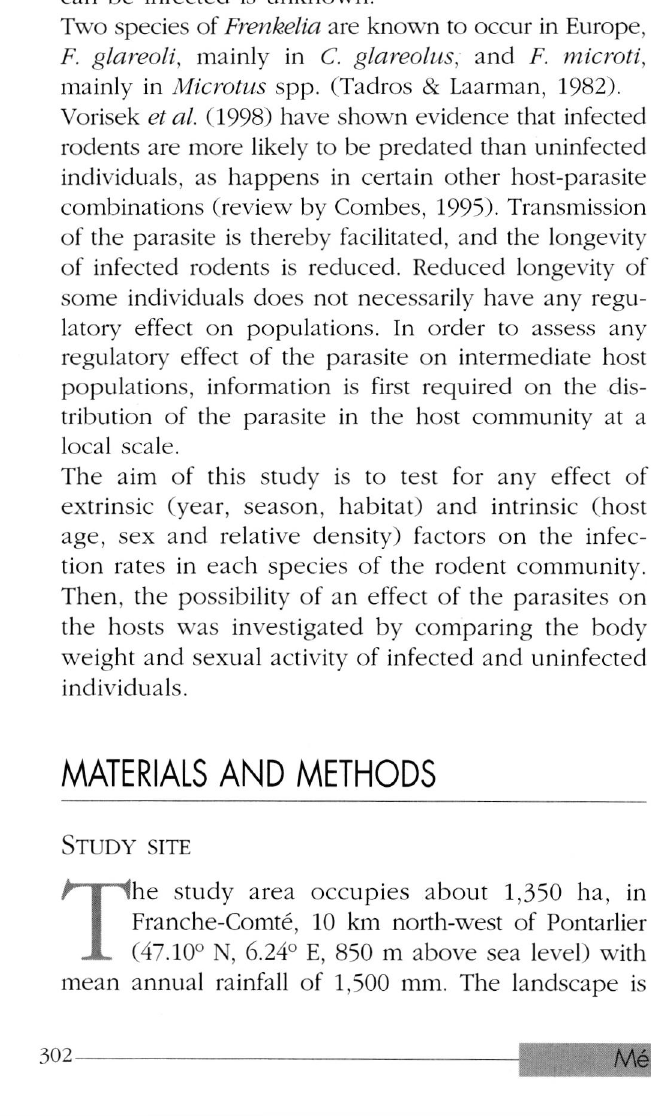
Fig. 1. - Landscape composition of the study site located in the Jura plateau.